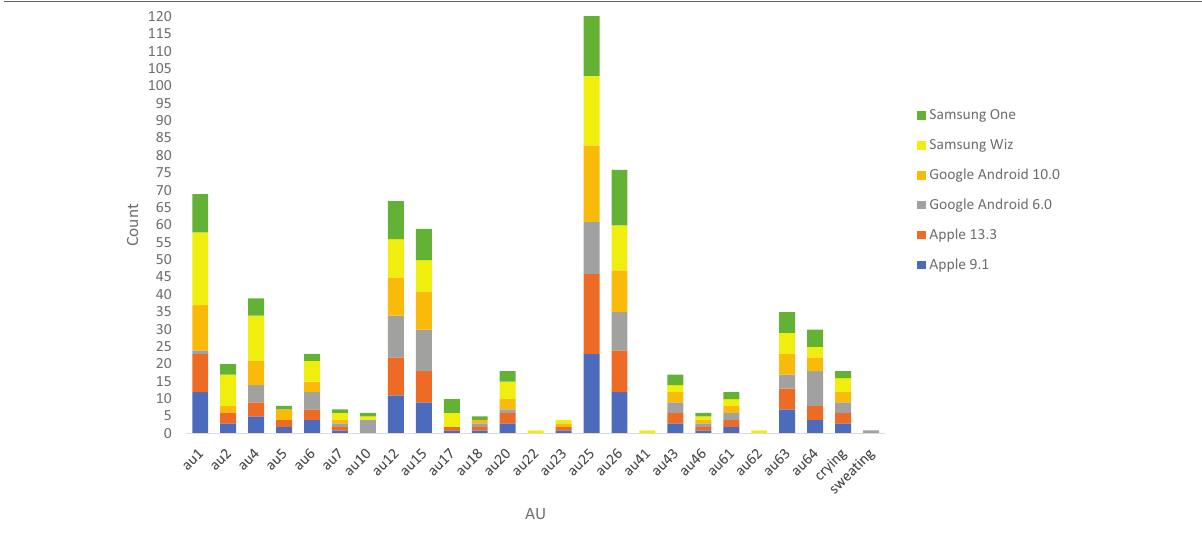
TABLE 4 | AU counts by